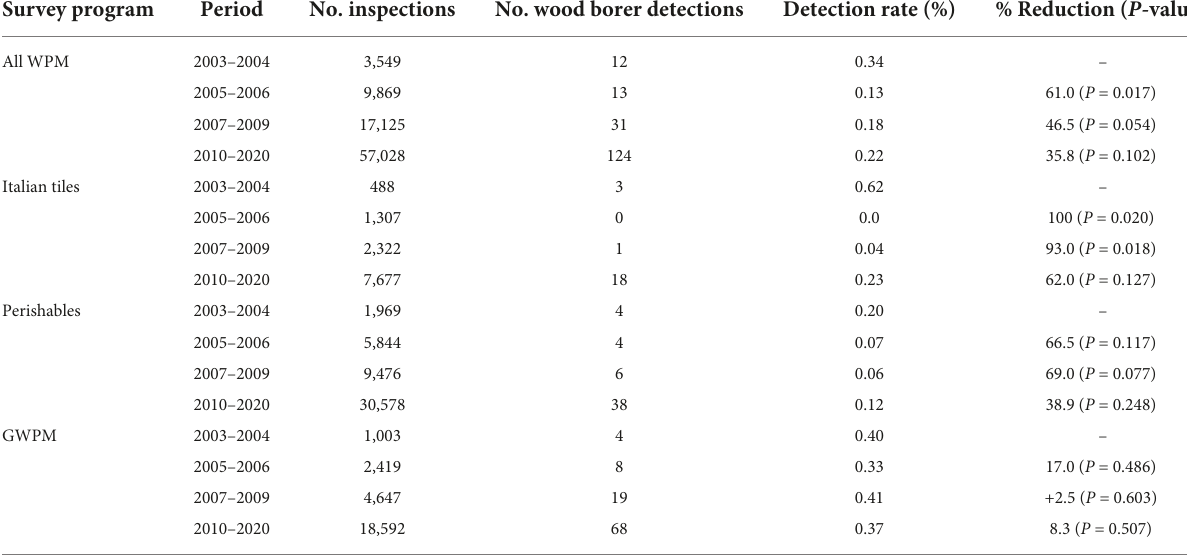
TABLE 4 Detection rates (%) of borer-infested WPM inspected as part of the AQIM program during four time periods from 2003 through 2020 that bracket when the US implemented ISPM 15 in